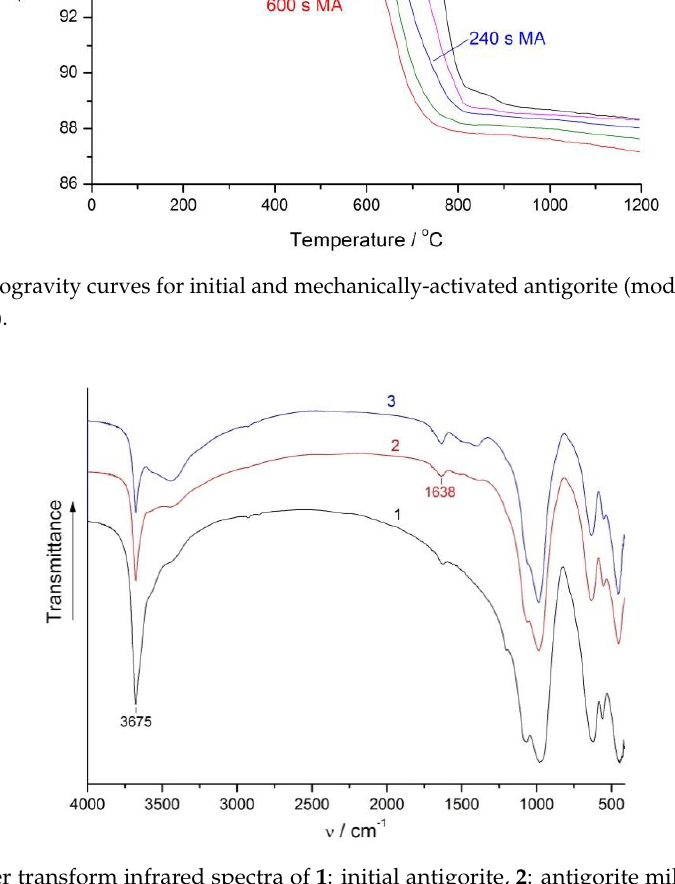
Figure 6. Fourier transform infrared spectra of 1 : initial antigorite, 2 : antigorite milled in moderate conditions for 600 s in air, 3 : alkali-activated binder prepared using antigorite milled for 600 s in moderate conditions in air and liquid glass with a modulus of 2.25 (the amount of liquid glass added corresponded to 3% Na 2 O, curing time in dry conditions was 28 days).